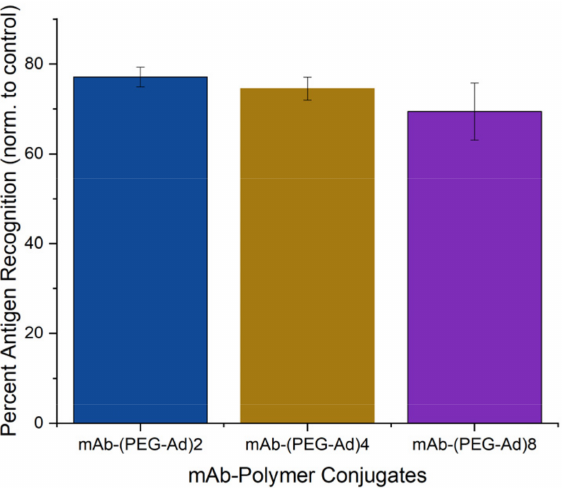
Figure 8. Quantitative estimation of mAb (anti-IL10) structure/function after PEG 5000 –Ad conjuga- tion. Positive controls (according to MabTag protocol, using unmodified primary antibodies) were assumed to have 100% antigen